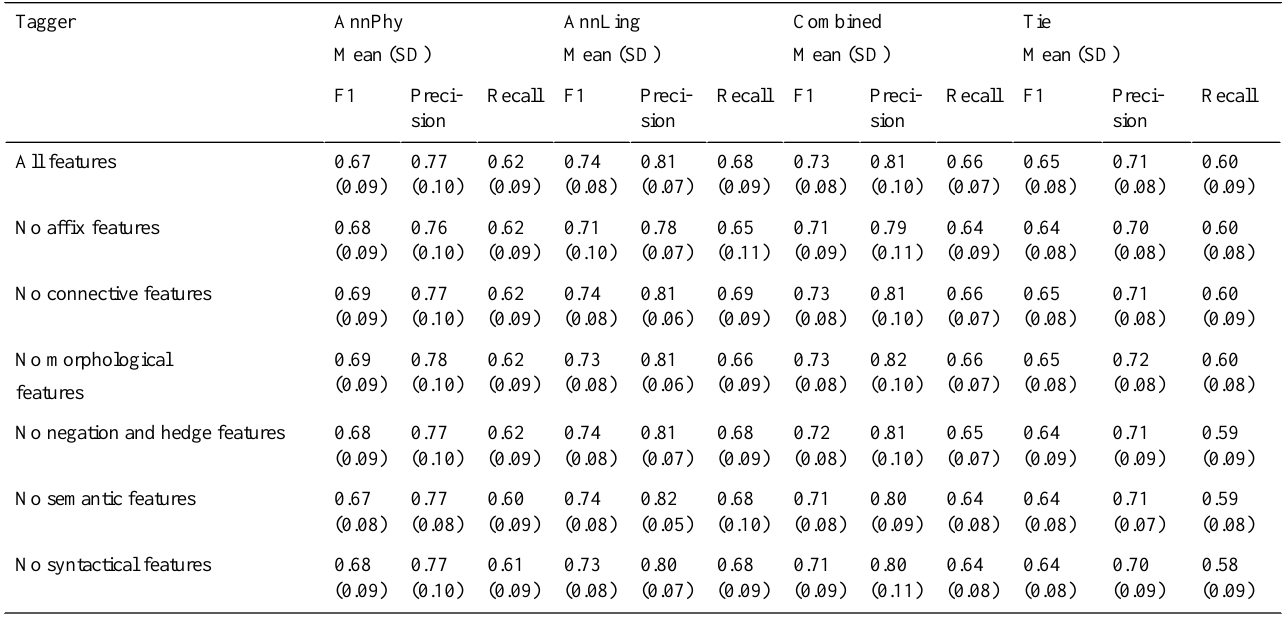
Table 5. The precision, recall, and F1 score of Taggers with feature categories removed one at a time on each of the four annotated data